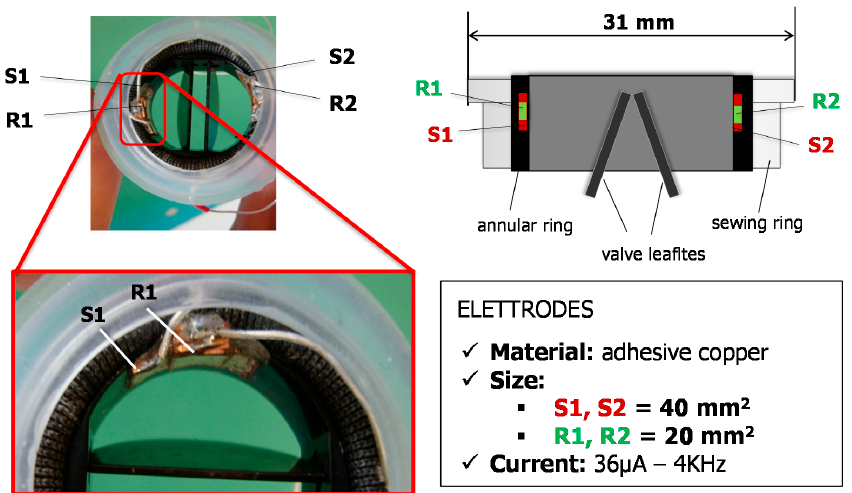
Figure 1. The principle of measurement of IntraValvular Impedance (IVI): Current pulses (I) are injected via source electrodes (S1, S2) to generate local electric field interfering with leaflet movement, and voltage ( ∆ V) is recorded between receiving electrodes (R1,